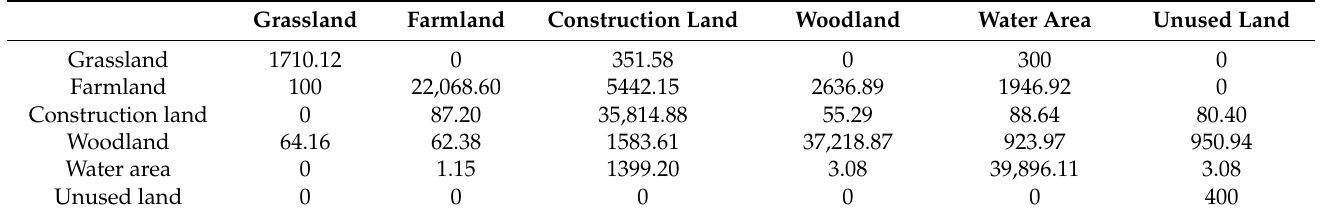
Table 7. Land-use transition matrix in ecological redline areas during 2005–2018 (ha). Grassland Farmland Construction Land Woodland Water Area 1710.12